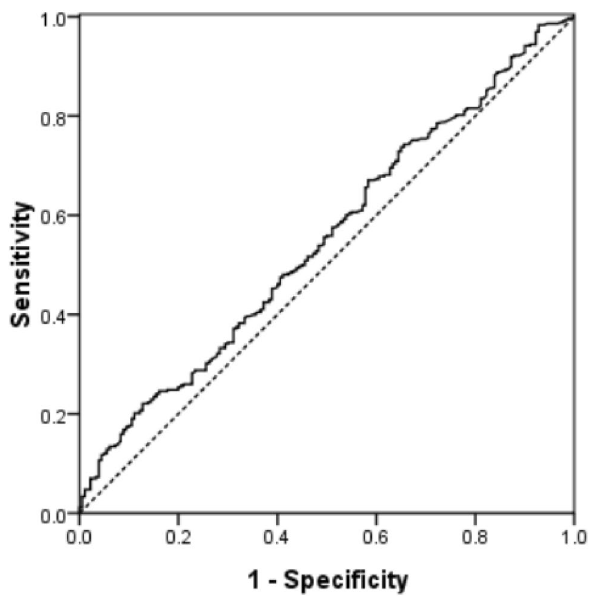
Figure 1. Receiver operator characteristic curve for prediction of ongoing pregnancy/live birth for cleavage- stage embryo transfers. The area under the curve is